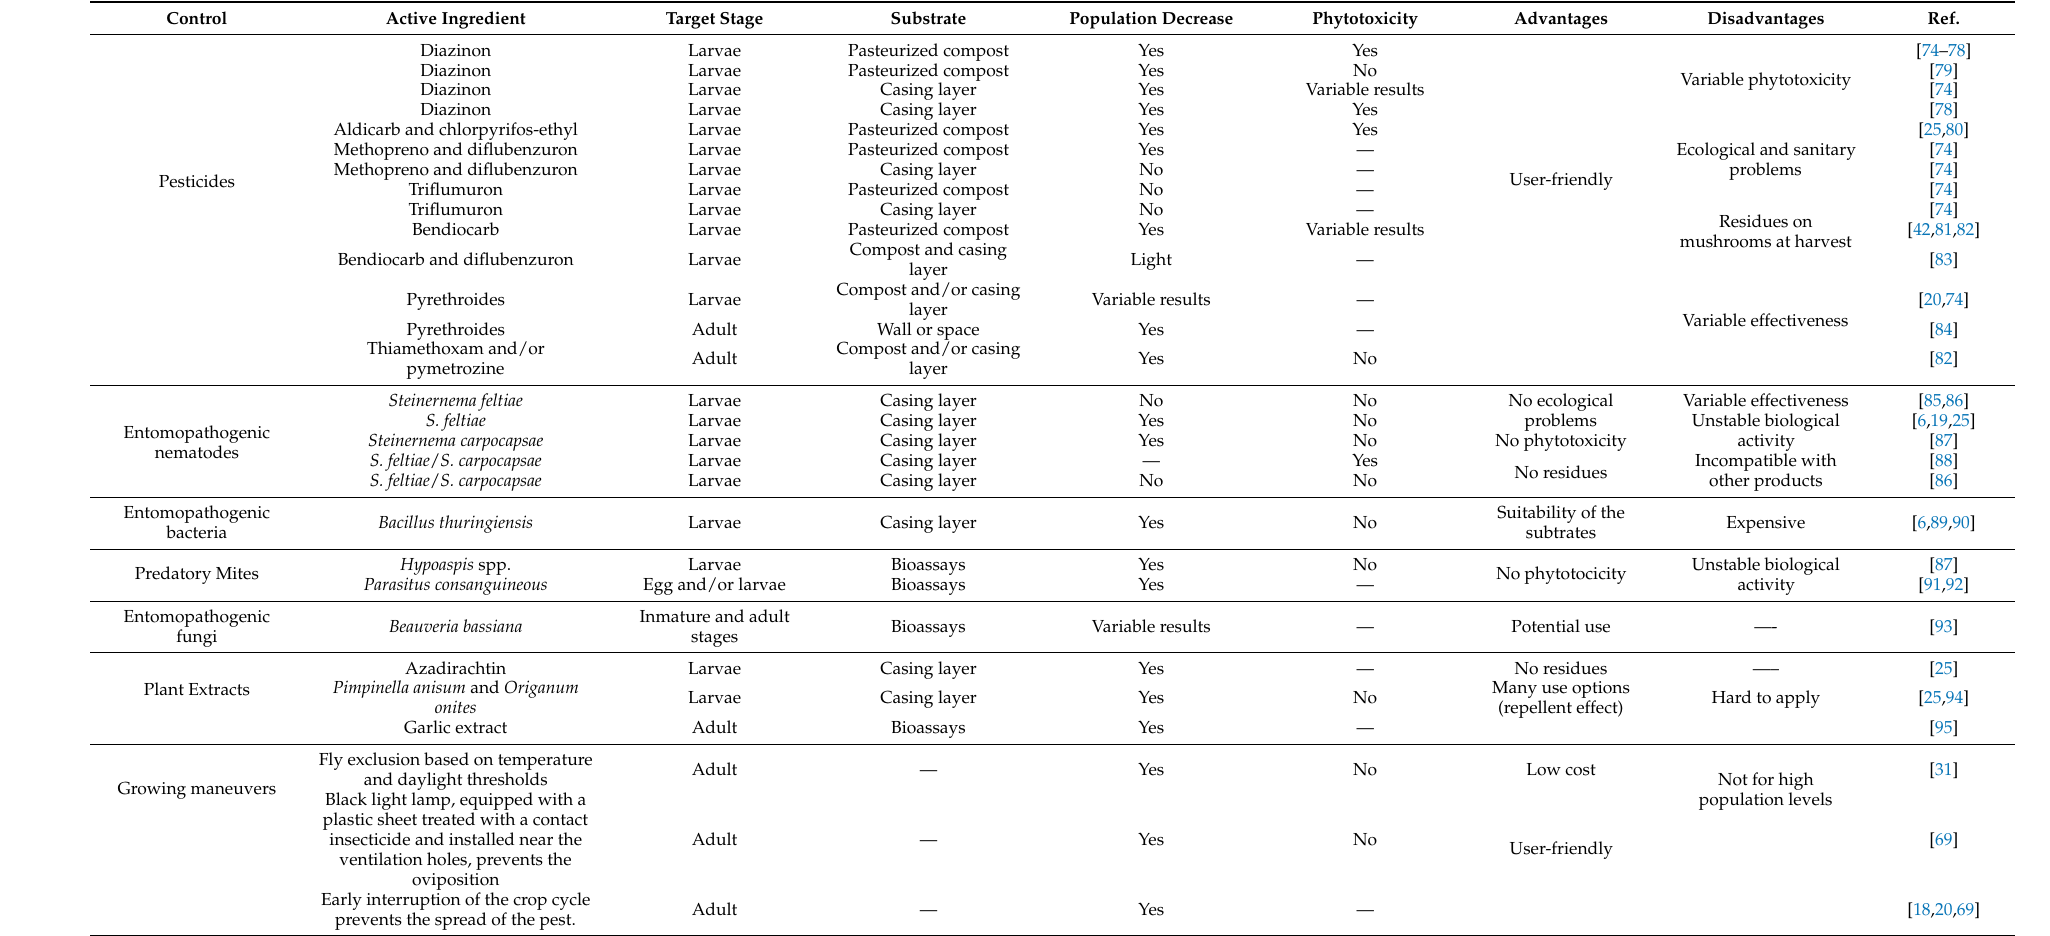
Table 2. Methods applied for the control of phorid flies in commercial mushroom